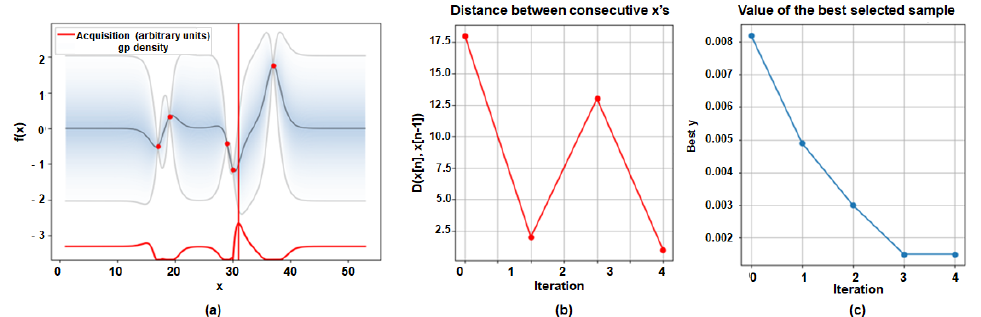
Figure 4. Visualization results of the optimal sharing layer configuration through BayesOpt using ‘EI’ as the acquisition function. (70 classes/30 classes) ( a ) The result of the selected optimal number of sharing layers. ( b ) The L2 distance of the consecutive observed points. ( c ) The value of the calculated best-selected sample for every